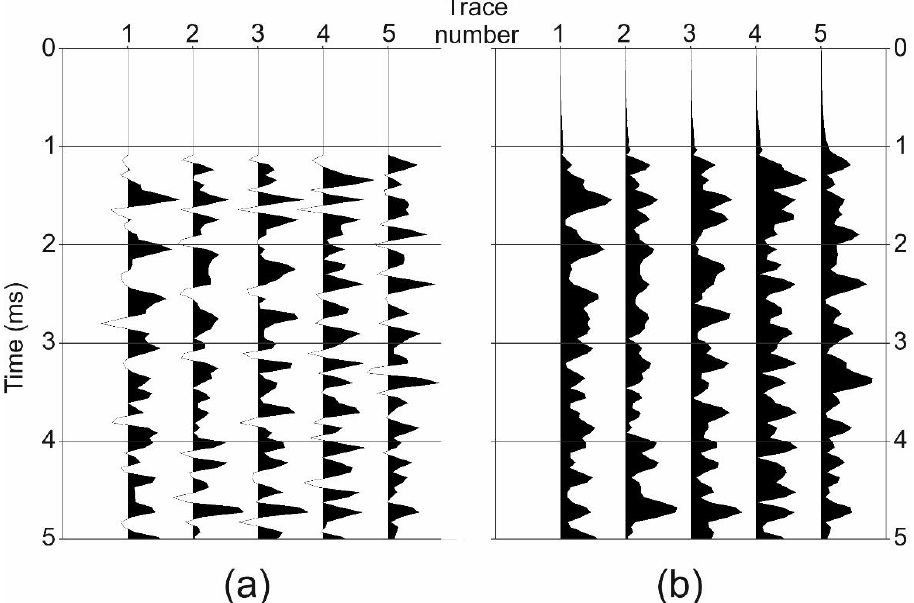
Figure 1. Chirp data before ( a ) and after the envelope operator ( b ).